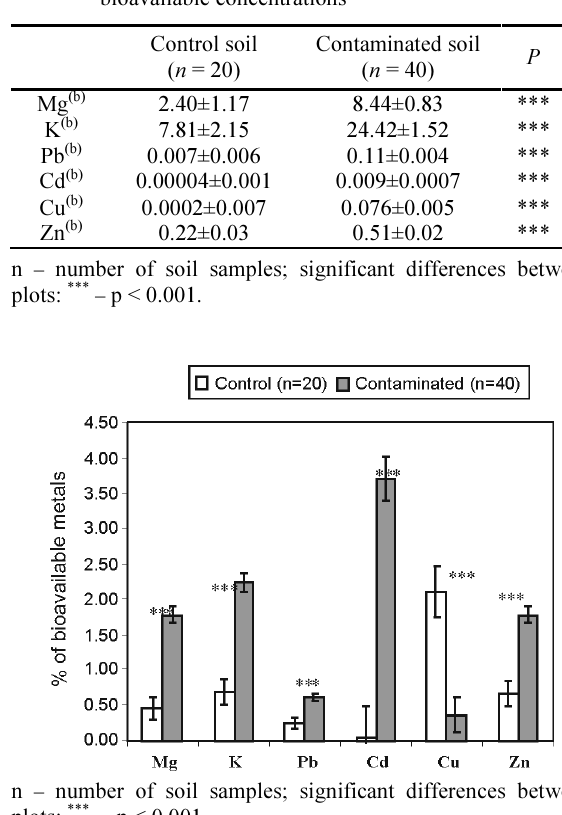
Table 3. Bioavailable metals in control and contaminated soils.